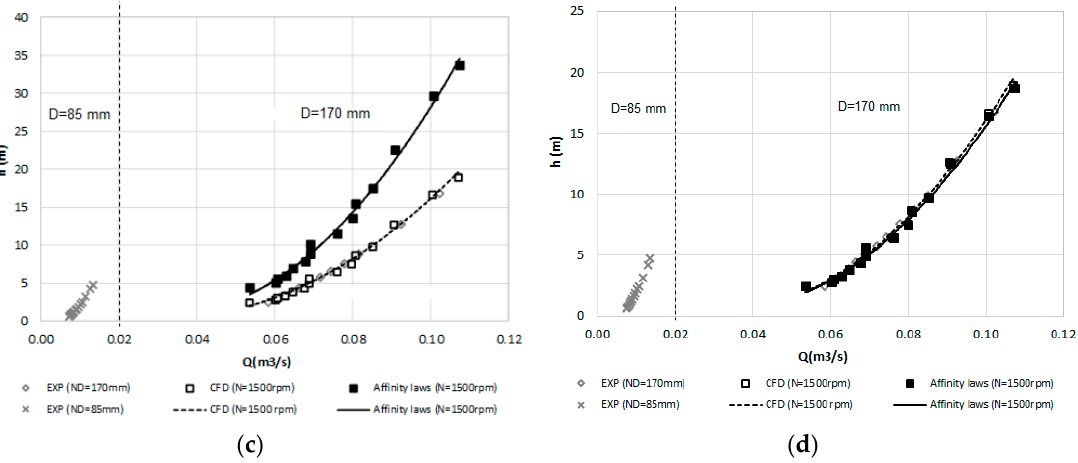
Figure 6. Numerical results vs. affinity laws proposed by [21]: ( a ) flow vs. efficiency; ( b ) flow vs. power; ( c ) flow vs. head; ( d ) flow vs. head with modified affinity laws.